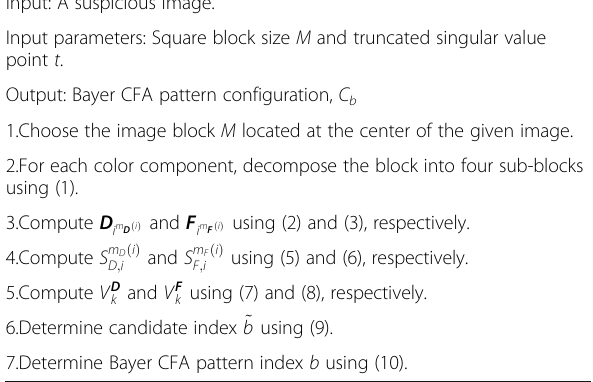
Table 2 Probabilities of V D for various demosaicing algorithms (Bayer configuration þ V F 2 C 1 is used)